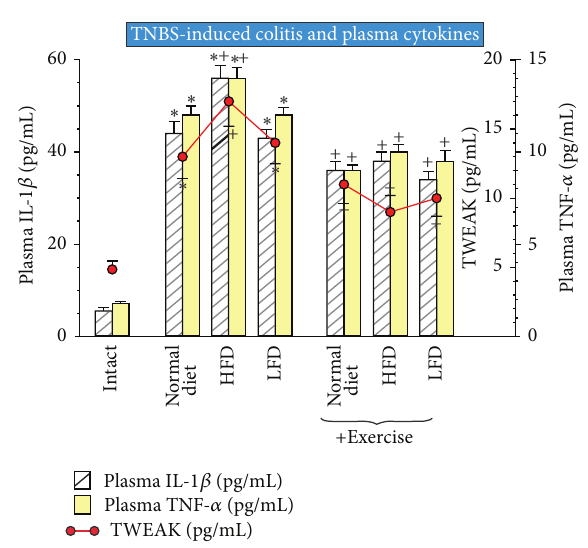
Figure 5: The effect of exercise on the plasma levels of proinflam- matory cytokines IL-1 𝛽 and TNF- 𝛼 and TWEAK in TNBS rats fed normaldiet,HFD,orLFDwithorwithoutexercise.Resultsaremean ± SEM of eight animals per each experimental group. Asterisk indi- cates a significant change ( 𝑃 < 0.05 ) as compared with respective values in intact rats. Asterisk and cross indicate a significant change ( 𝑃 < 0.05 ) as compared with respective values in animals fed with normal diet. Cross indicates a significant change ( 𝑃 < 0.05 ) as compared with those obtained in untrained animals.